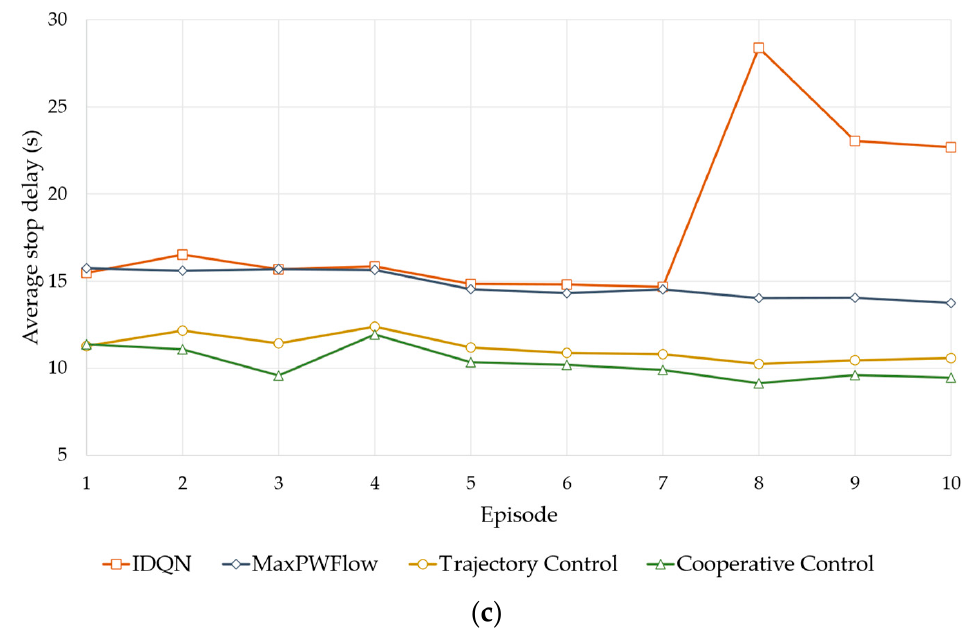
Figure 5. Performance measurements for the “Cologne-316” scenario: ( a ) Average fuel consumption; ( b ) Average travel time; ( c ) Average stop delays.